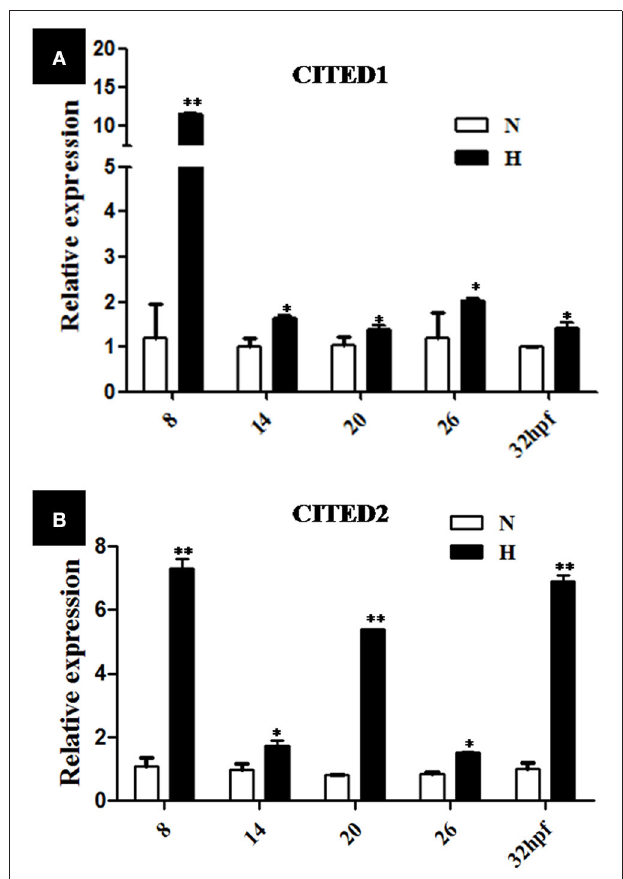
FIGURE 5 | q RT-PCR analysis of CITED1 (A) and -2 (B) mRNAs at different development stages of blunt snout bream embryos after treatment with hypoxia (DO = 3.5 ± 0.5 mg/L) for 6h starting at 2-, 8-, 14-, 20-, or 26 hpf stage. H, hypoxia treatment (DO = 3.5 ± 0.5 mg/L) for 6h starting; N, normoxia (DO = 7.0 ± 0.5 mg/L), The results are presented as mean ± SE ( n = 5), * p < 0.01; ** p <